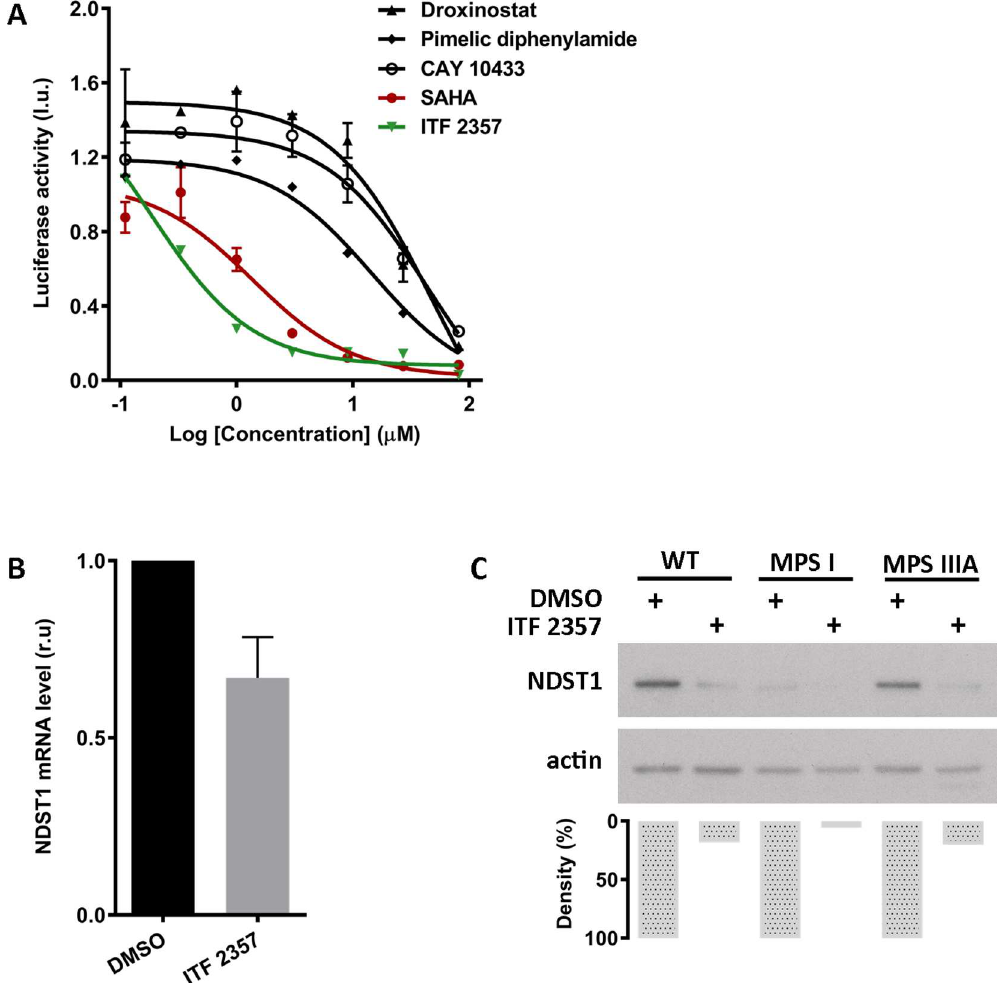
Fig 6. Histone deacetylase(HDAC) inhibitor assessment. (A) Dose-response of HDAC inhibitorson NDST1 promoter. HeLa cells stably expressing the NDST1 promoter—luciferasereporter gene were treated with serially diluted selected HDAC inhibitors. ITF 2357, an HDAC inhibitor which is structurally and functionally similar to SAHA, produceda dose-response curve with IC 50 of 0.2 μ M. Experiments were performed in duplicates. (B) NDST1 mRNA level after treatment with ITF 2357. Normal human fibroblast cells were treated with 2x IC 50 (0.4 μ M) of ITF 2357 for 5 days. Level of NDST1 mRNA was reduced by 40% after the treatment. Expressionof NDST1 mRNA level was normalized to 18S rRNA level. Experiments were conductedin duplicates. (C) Western blot densitometry analysisof NDST1 protein expression after treatment with ITF 2357. Normal human fibroblast, MPS I patient, and MPS IIIA patient cells were treated with ITF 2357 at its calculated 2x IC 50 . The effect of the compoundon the NDST1 expression was evaluatedusing densitometry analysisof NDST1 band normalized to its corresponding actin band. Significant decrease in NDST1 expression was observed in all treated cells. l.u.– luminescence units. r.u.–relative